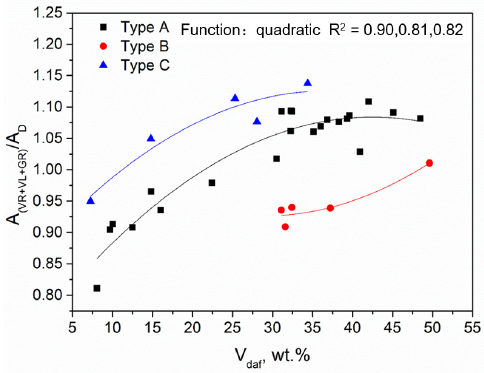
Figure 3. The correlation between V daf in parent coal and A (GR+VL+VR) /A D of its pyrolytic char. The chars of type A, B, and C were from coals with 10% < A ad < 30%, A ad < 10%, and A ad > 30%, respec- tively.